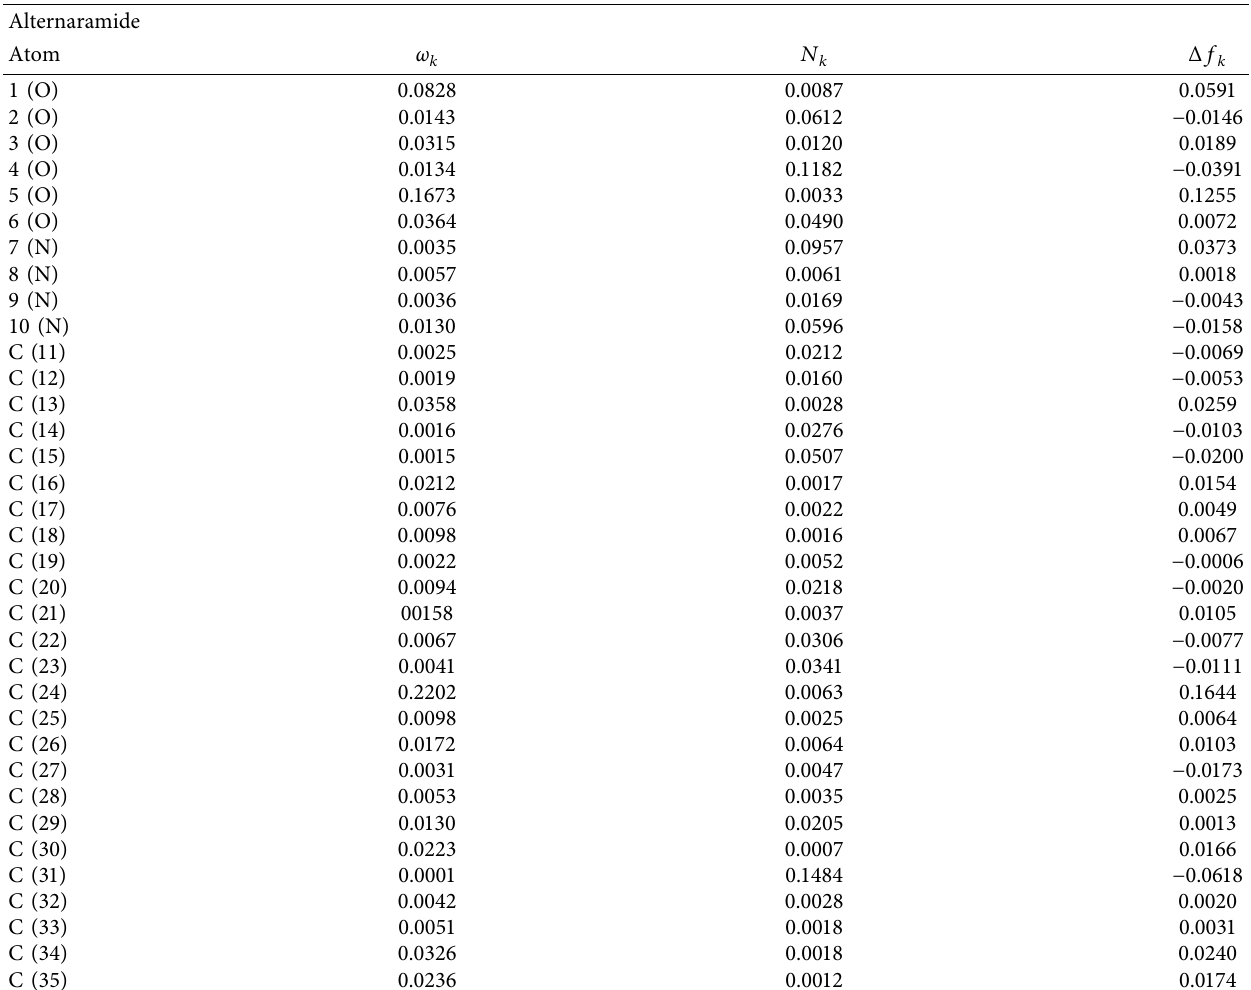
Table 5: Comparison of several reactivity descriptors: condensed electrophilicity ω